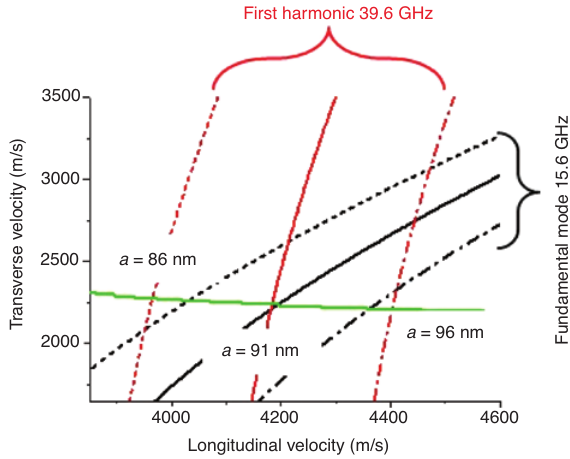
Figure 23: The black and red curves give the sound velocity compatible with the resonance frequencies of first (15.6 GHz) and second (39.6 GHz) breathing modes respectively, and the green curve is deduced from the Young’s modulus equal to 116 GPa [30]. These measurements have been performed in polycrystalline copper nanowire. Only the set of curve computed with a = 91 nm are able to reproduce simultaneously all the experimental